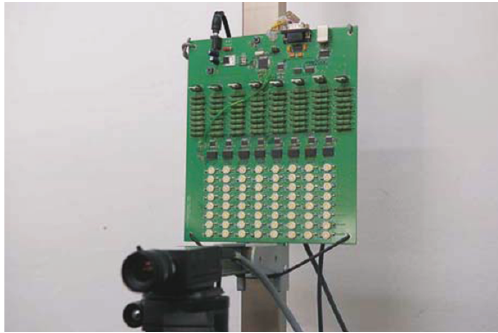
Figure 1: A dedicated flashing system, which captures lit and unlit frames